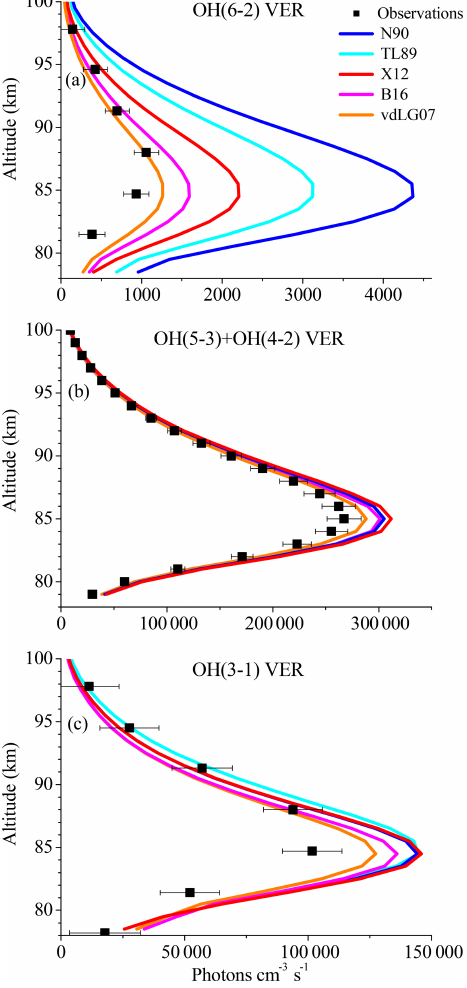
Figure 2. Same as Fig. 1 but for different sets of Einstein coef- ficients from literature, namely N90 (Nelson et al., 1990), TL89 (Turnbull and Lowe, 1989), X12 ( = base model; Xu et al., 2012), B16 (Brooke et al., 2016), and vdLG07 (van der Loo and Groenen- boom,